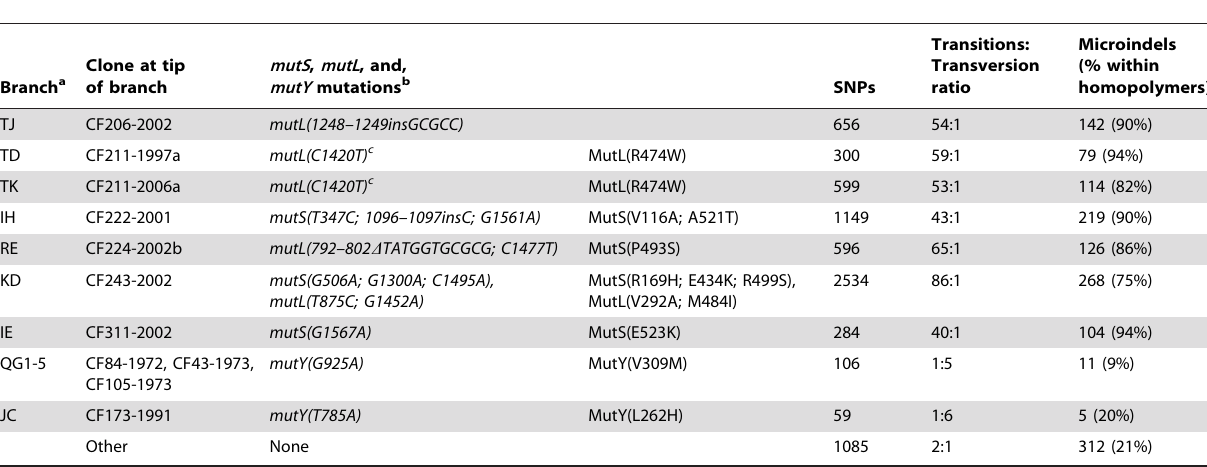
Table 1. Statistics on mutations accumulated in hypermutable sub-lineages.